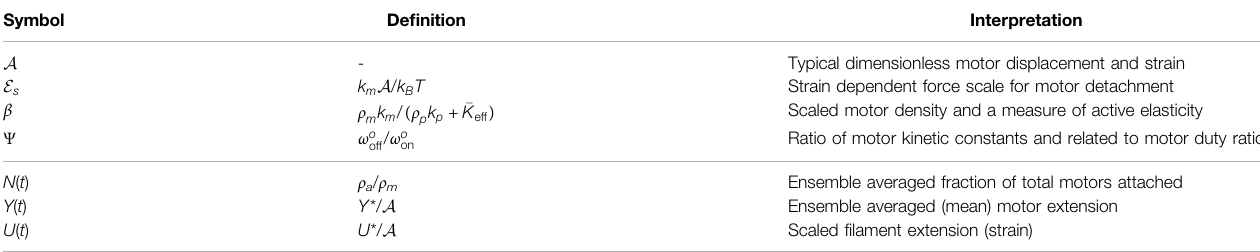
TABLE 1 | Motor-related parameters and scaled variables in the minimal model.